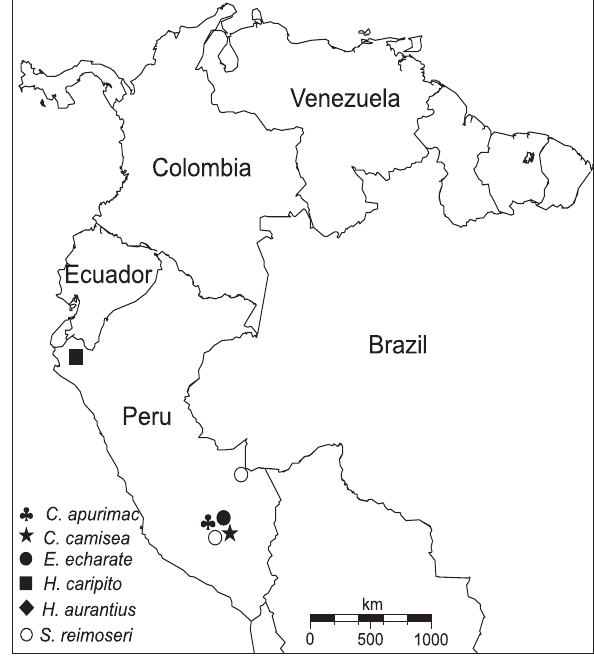
Figure 1. Distributions of C. apurimac sp. nov. , C. camisea sp. nov. , Enna echarate sp. nov. , H. caripito , H. aurantius and S. reimoseri in Peru and